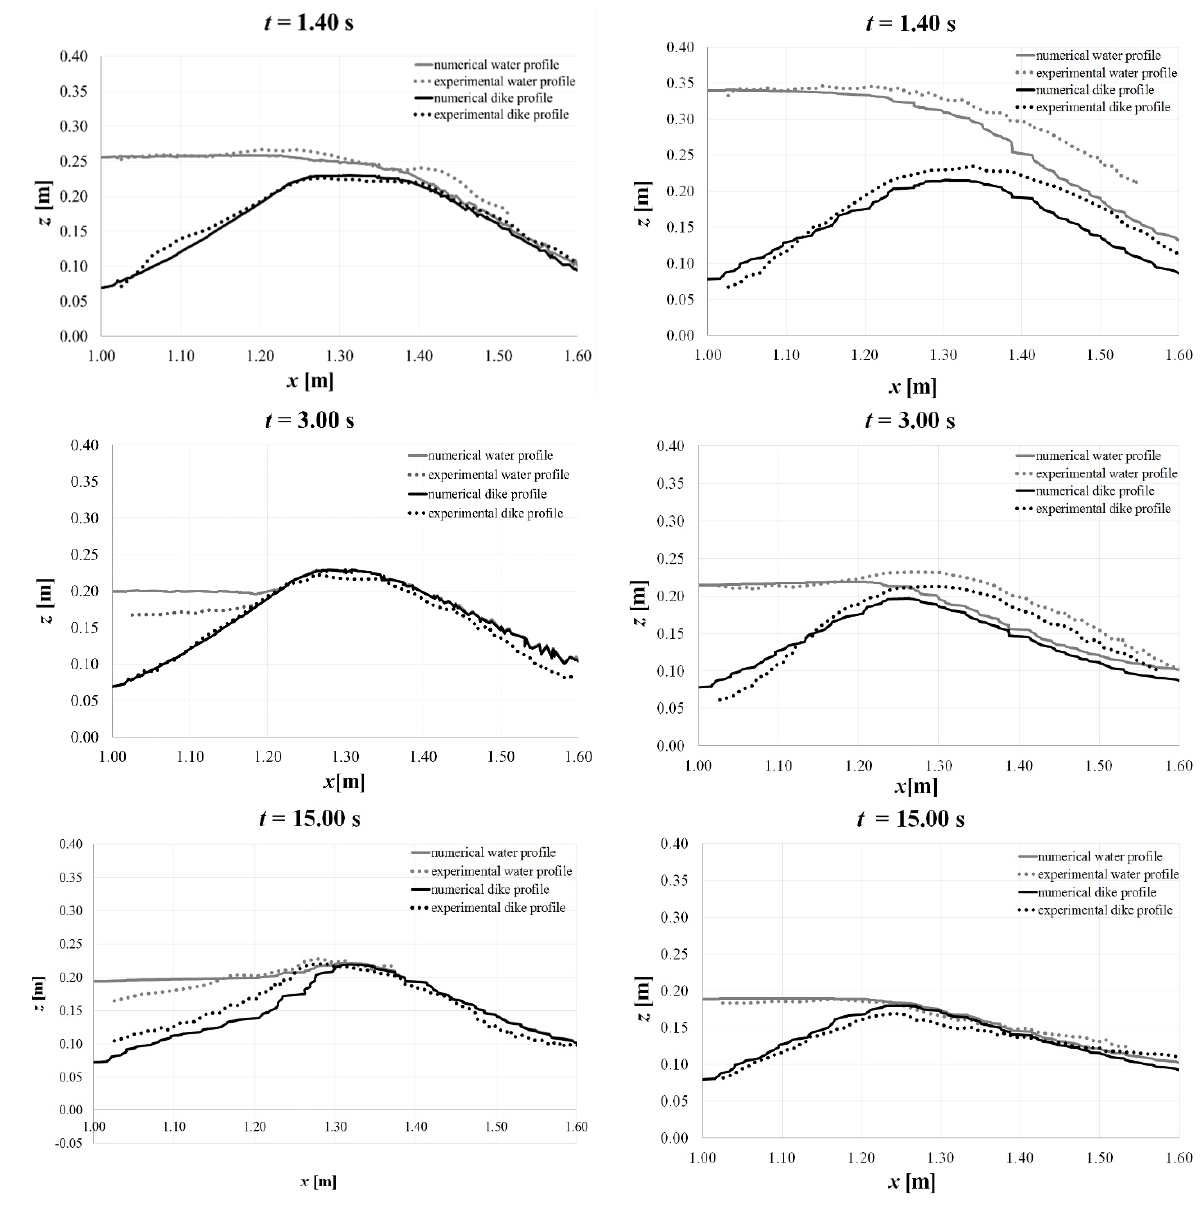
Figure 12. Comparison of the experimental results (dotted lines) against the numerical ones (solid lines) for Test B2 ( a ) and Test B3 ( b ): water (grey) and dike (black) profiles at times t = 1.40, 3.00 and 15.00 s,